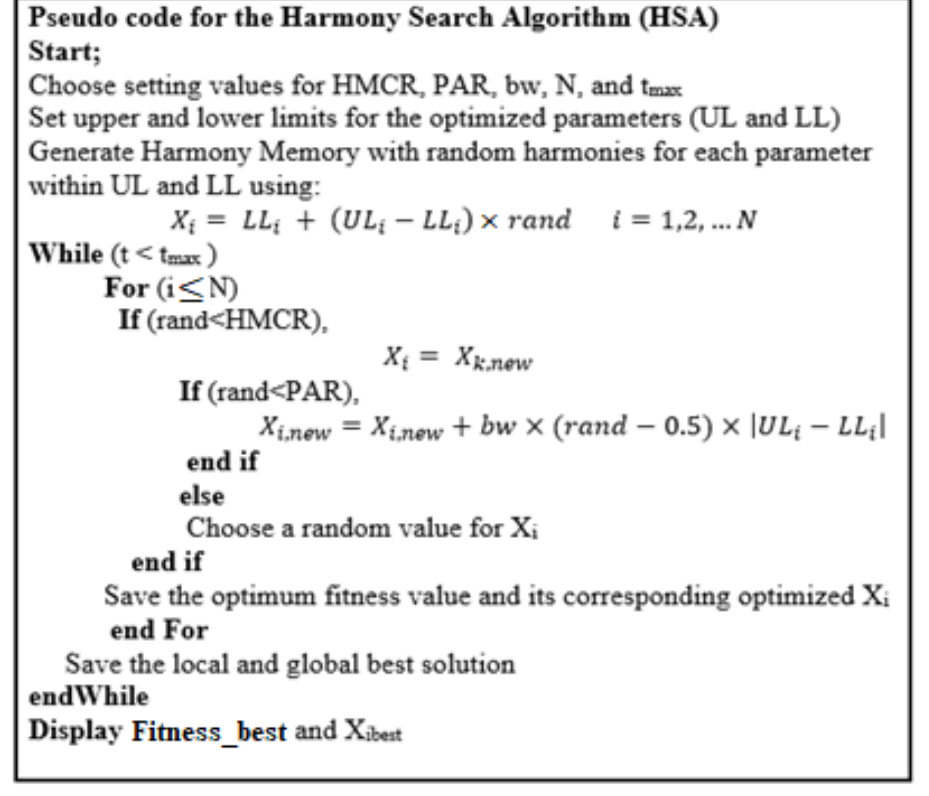
Figure 4. Pseudo code for HSA.